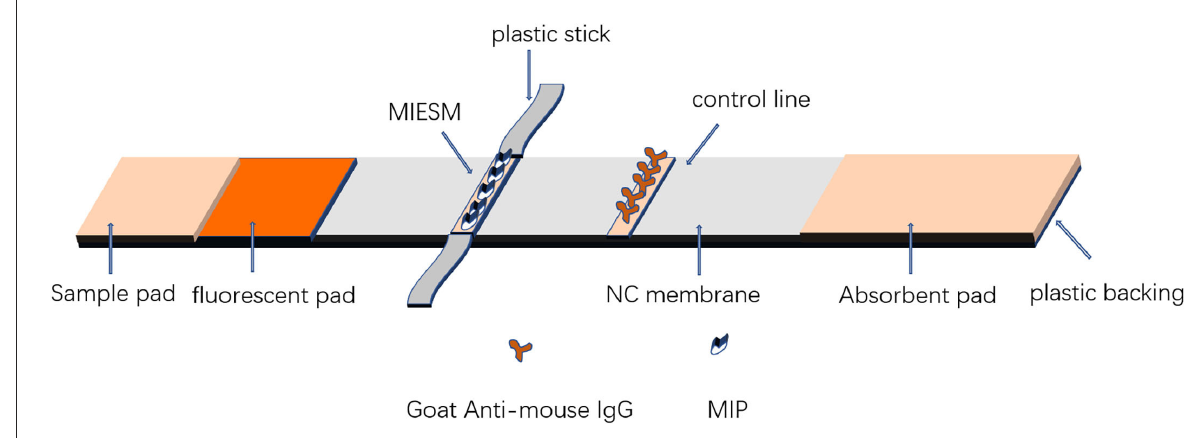
FIGURE2 Assembly of the biomimetic immunochromatographic strip assay.